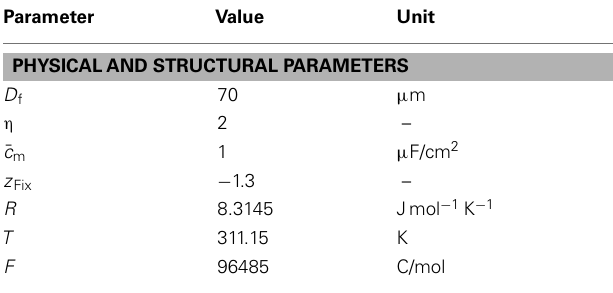
Table 2 | Parameters of the catastrophe model.